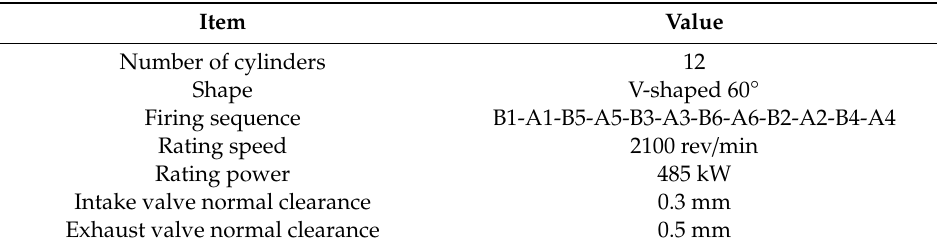
Table 1. Features of the TBD234V12 diesel